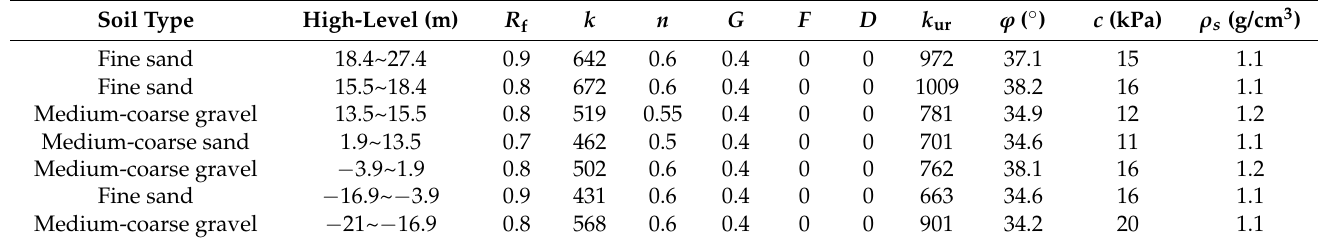
Table 2. Soil parameters of the Duncan – Chang (DC) model used in this paper [29].